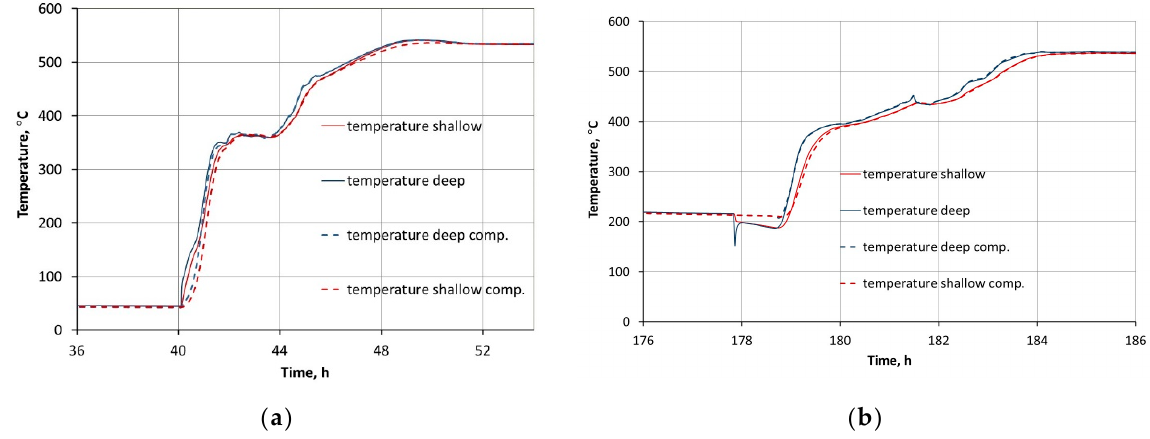
Figure 11. Comparisons of temperature changes as computed by the FEM and measured over time for selected points of the Y-junction; calculations were made for α determined on the basis of Nu number: ( a ) cold startup, ( b ) hot startup.